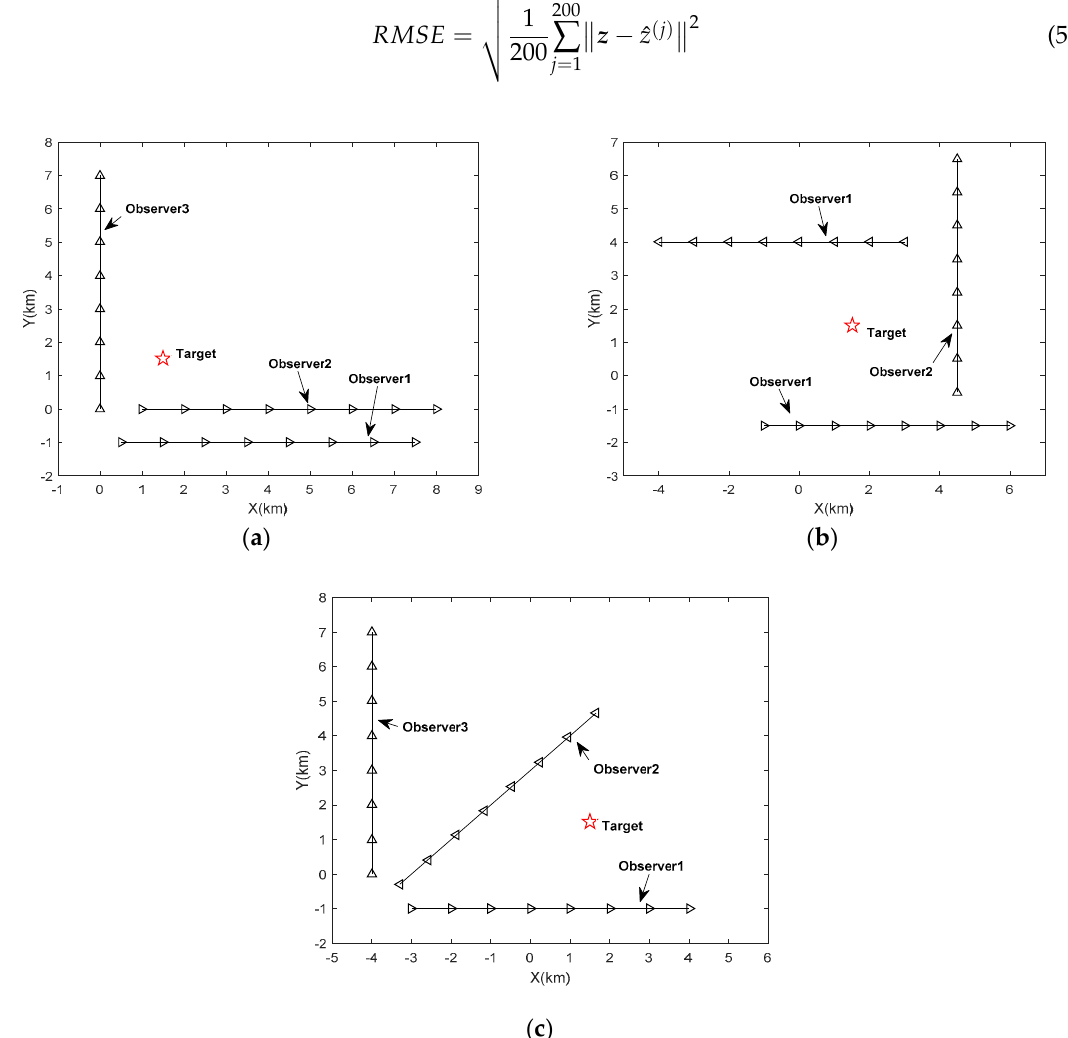
Figure 1. Position of target and the trajectories of receivers. ( a ) Scenario a; ( b ) scenario b; ( c ) scenario c.